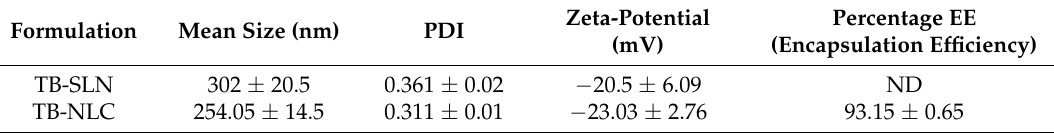
Table 2. Characteristics of nanoparticle (TB